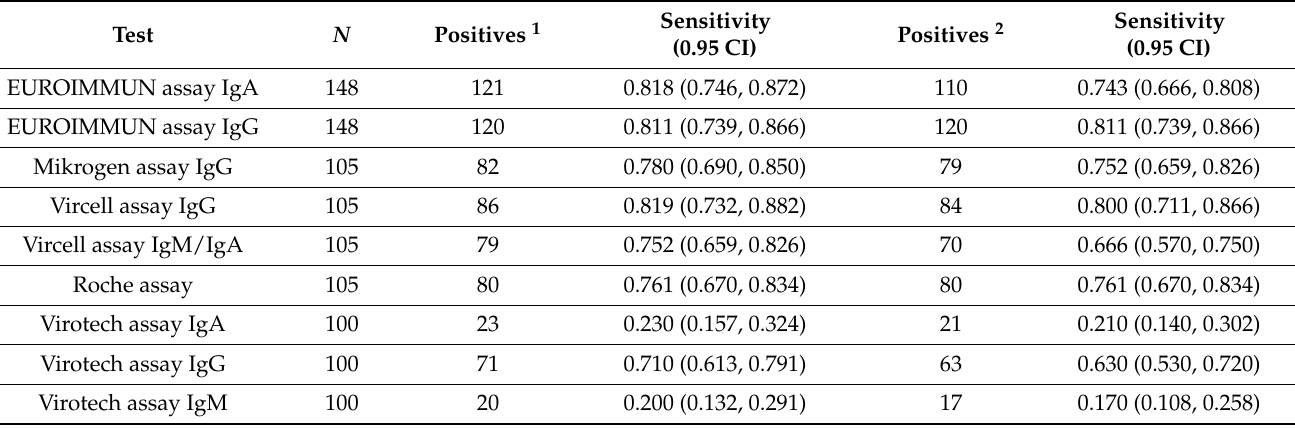
Table 1. Sensitivities of the assessed